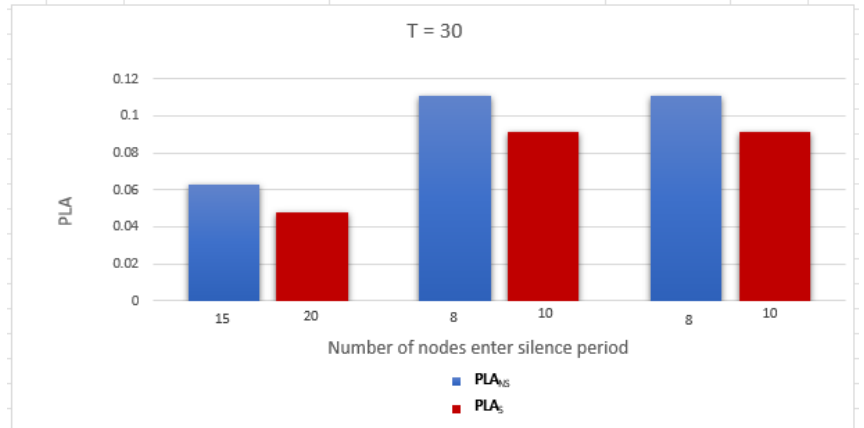
Figure 13. Probability of linkability (PLA) of the source node in a network with 30